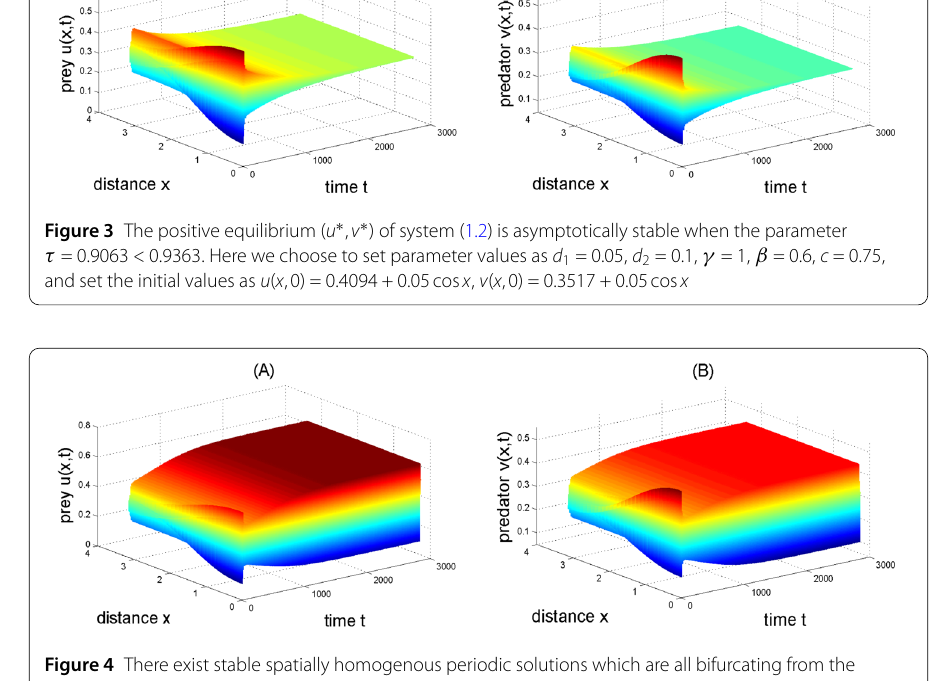
Figure 4 There exist stable spatially homogenous periodic solutions which are all bifurcating from the positive equilibrium ( u ∗ , v ∗ ) of system (1.2) when the parameter τ = 0.9463 > 0.9363. Here we choose parameter values d 1 = 0.05, d 2 = 0.1, γ = 1, β = 0.6, c = 0.75, and then set the initial values as u ( x ,0) = 0.4094 + 0.05cos x , v ( x ,0) = 0.3517 + 0.05cos